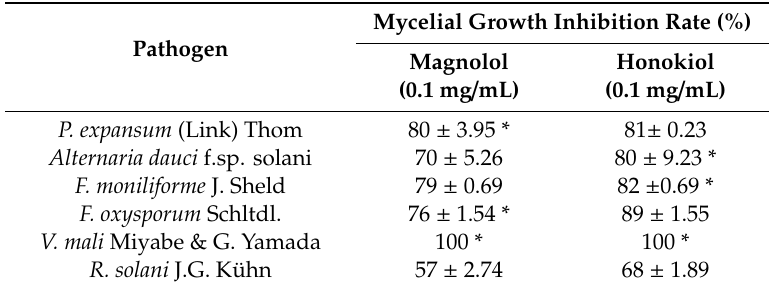
Table 3. The inhibitory e ffi ciency of magnolol and honokiol against six phytopathogens. Mycelial Growth Inhibition Rate (%) Pathogen